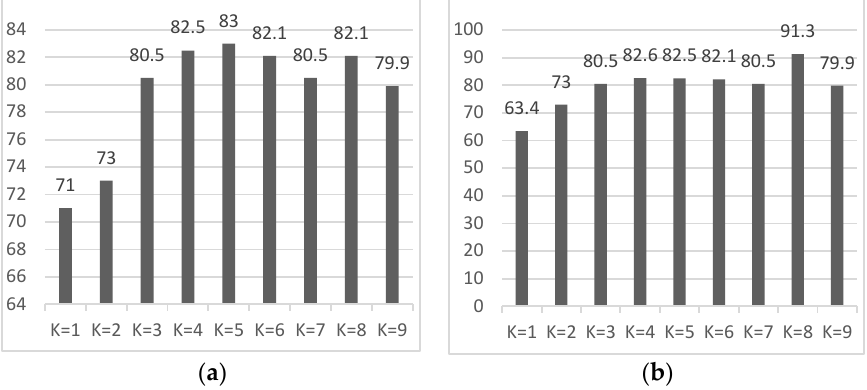
Figure 9. Accuracy under different K values. ( a ) Chi-square test; ( b ) Mutual information.